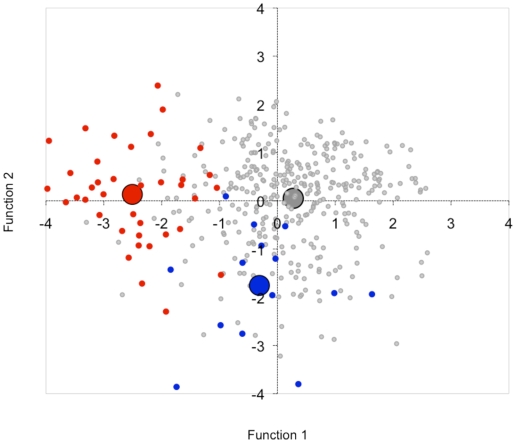
Plot of individual subject canonical function coefficients of the 3-group discriminant analysis for heterogeneous ASD (grey dots) versus 22q11DS-ASD (red dots) versus KS-ASD (blue dots), the larger dots represent the group centroids.22q11DS-ASD is predominantly discriminated from heterogeneous ASD by function 1, KS-ASD from heterogeneous ASD by function 2.